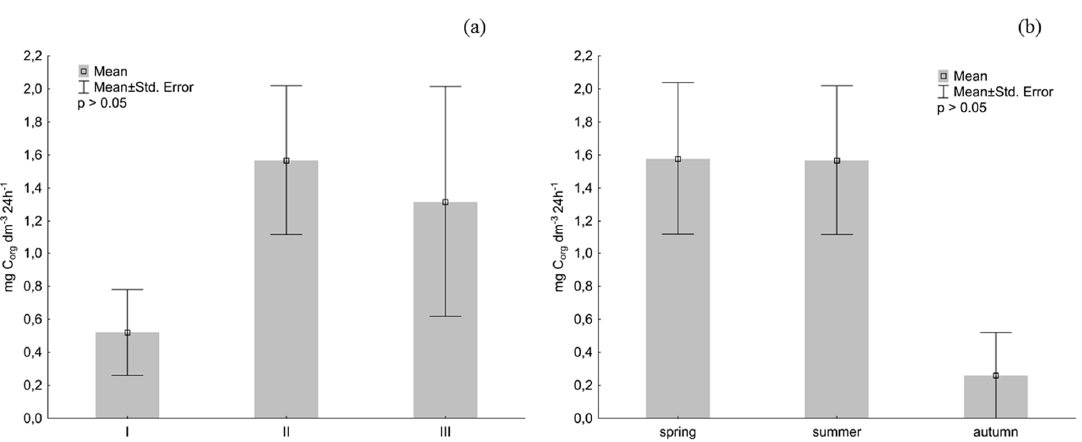
Figure 5. Rate of organic carbon oxidation by planktonic bacteria ( a ) at the research sites, ( b ) in the research seasons.